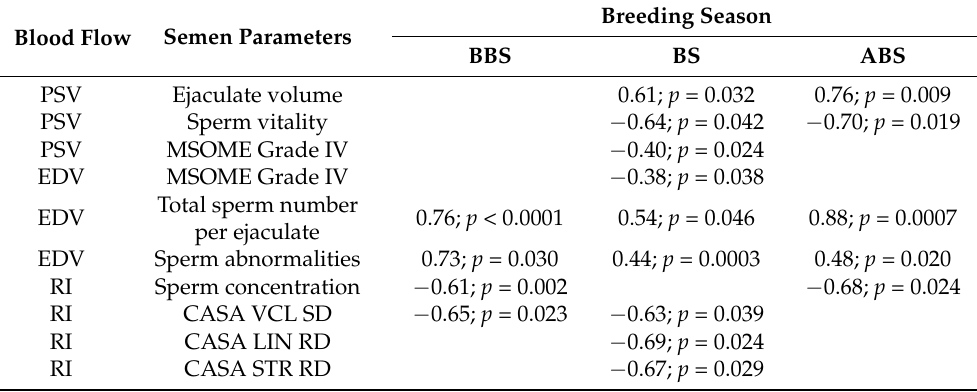
Table 5. Spearman correlation coefficients ( ρ ) between the blood flow measures in the testicular artery and parameters of routine and advanced semen evaluation tests in the selected periods of routine ram examination in the herd, before the breeding season (BBS), during the breeding season (BS), and after the breeding season